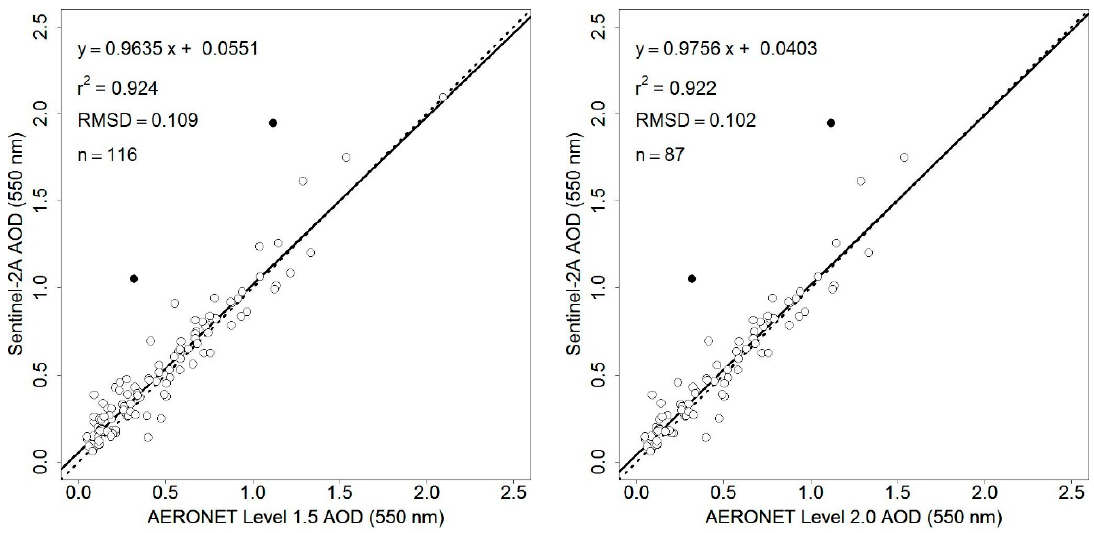
Figure 4. Scatterplots of the Sentinel-2A AOD against the contemporaneous AERONET Level 1.5 ( left ) and Level 2.0 ( right ) AOD data over the urban AERONET sites for 2016. The two filled circles are outliers due to Sentinel-2A cloud detection omission errors and are not used in statistics analysis. The solid lines show ordinary least square regression lines. The dotted lines are 1:1 lines superimposed for